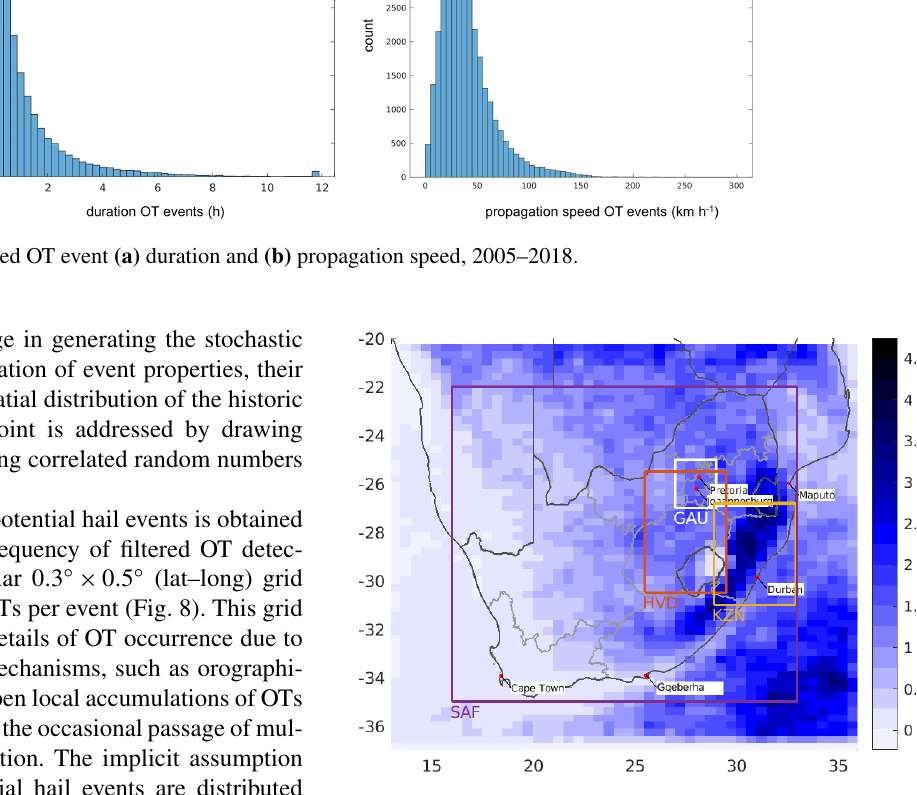
Figure 8. Event frequency distribution used for stochastic model- ing. The boxes show different regions discussed in Sect. 3.6: the greater South Africa domain (SAF, purple box; for simplicity de- fined as the area between 35 and 22 ◦ S and 16 and 33 ◦ E), the High- veld (HVD, red box), and KwaZulu-Natal (KZN, yellow box) are shown as the most populated and most storm-affected regions, and the Gauteng (GAU) region is shown as the largest contiguous urban area with a significant concentration of